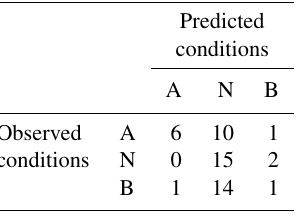
Figure 13. Observed versus predicted number of JFM wet days for six stations across 1966–2016.